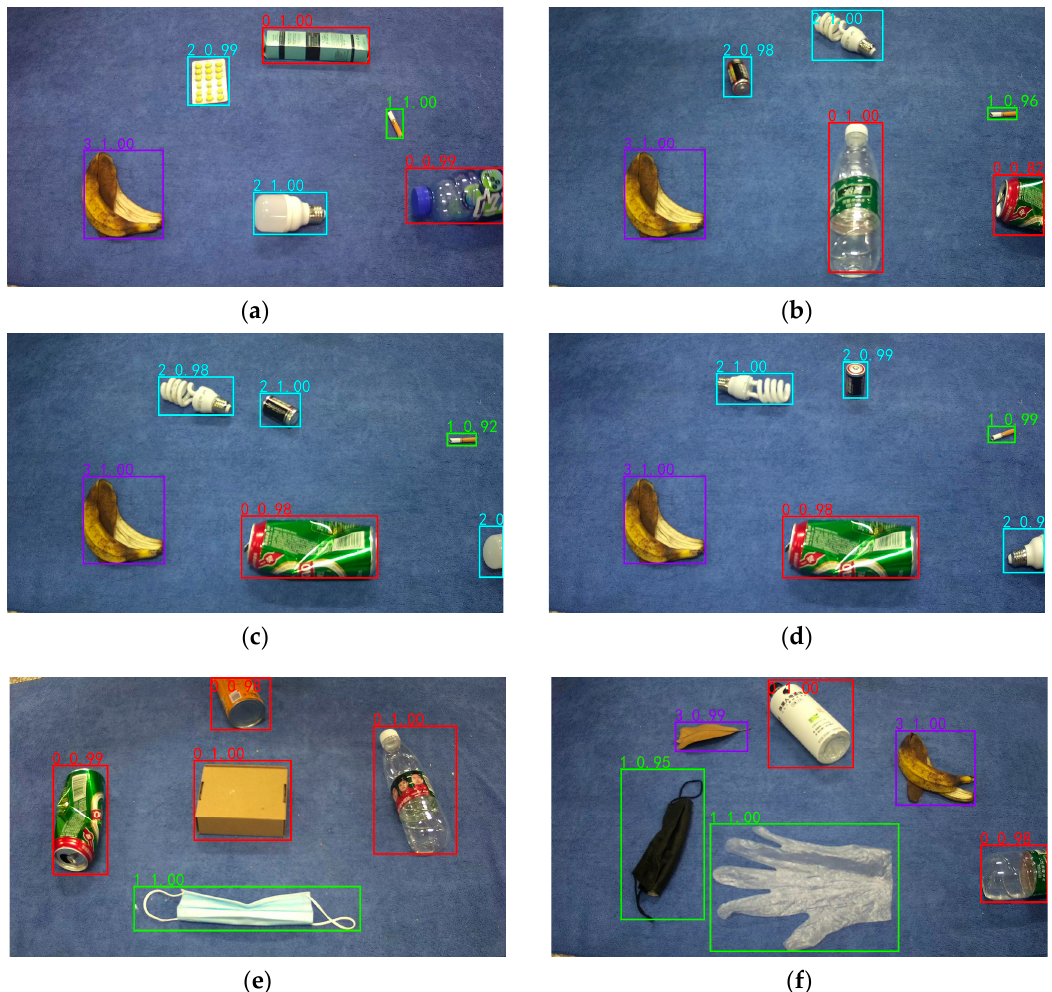
Figure 12. Experimental test results with obscured targets: ( a ) test image 1; ( b ) test image 2; ( c ) test image 3; ( d ) test image 4; ( e ) test image 5; and ( f ) test image 6.